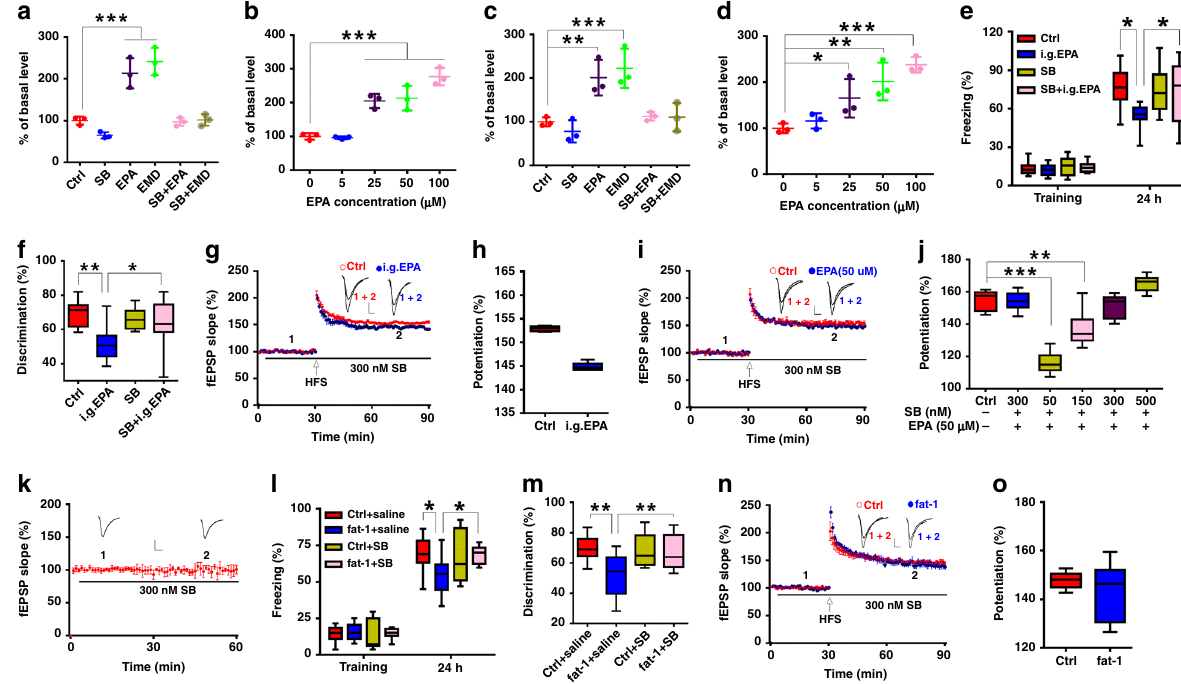
Fig. 4 5-HT6R mediated the impairing effect of EPA on behavior and synaptic plasticity. a – d EPA-stimulated cAMP production was mimicked by the 5- HT 6 R agonist EMD-368088 (EMD,10 μ M) but completely blocked by the 5-HT 6 R antagonist SB-399885 (SB, 300 nM) in 293T cells transfected with the mouse ( a , b ) or human ( c , d ) 5-HT 6 R plasmid ( n = 3 wells/group; one-way ANOVA; a : F (5, 12) = 48.668, P < 0.0001; b : F (5, 12) = 55.89, P < 0.0001; c : F (5, = 61.268, P < 0.0001; d : F = 62.109, P = 0.001). e – h The 5-HT n = 9 – 11 mice/ (4, 10) 6 R antagonist SB blocked the impairment in learning and memory ( e : 12) group; one-way ANOVA, F (3, 36) = 43.560, P = 0.024;( f ): n = 9 – 10 mice/group; one-way ANOVA, F (3, 35) = 45.455, P = 0.003) and LTP ( g, h , n = 5 slices/group; two-tailed Student ’ s t -test, P = 0.518) induced by i.g. administration of 50 mg/kg EPA. i , j SB prevented EPA-impaired LTP in a concentration-dependent manner ( n = 6 – 11 slices/group; one-way ANOVA, F (5, 40) = 50.89, P < 0.0001). k Bath application of SB after establishing the baseline recording did not affect fEPSP slope ( n = 5). l – o CA1 microinjection of the 5-HT 6 R antagonist SB (300 nM) rescued the impairments in behaviors in the contextual fear conditioning ( l , n = 8 – 12 mice/group; one-way ANOVA, F (3, 33) = 42.182, P = 0.019) and NOR test ( m , n = 8 – 10 mice/group; one- way ANOVA, F (3, 32) = 44.931, P = 0.006) and in LTP ( n , o , n = 6 slices/group; two-tailed Student ’ s t -test, P = 0.877) in fat-1 mice. Data show mean ±